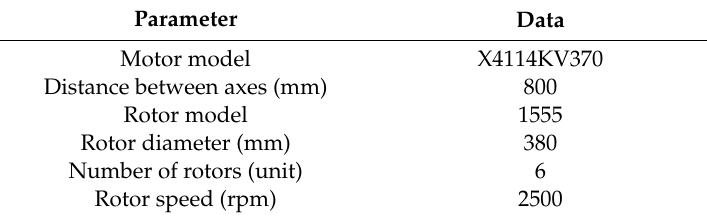
Figure 10. Test layout of test platform for full bridge flexible detection structure acquisition system. 1 = Power supply; 2 = Aluminum bracket; 3 =Support rod; 4 = Waterproof type amplification detection module; 5 = Lead; 6 = Polypropylene acquisition card; 7 = Dandelion X5 industrial grade router; 8 = Waterproof electric control box; 9 = Cable; 10 = Single bridge acquisition system; 11 = Full bridge acquisition system; 12 = Half bridge acquisition system.